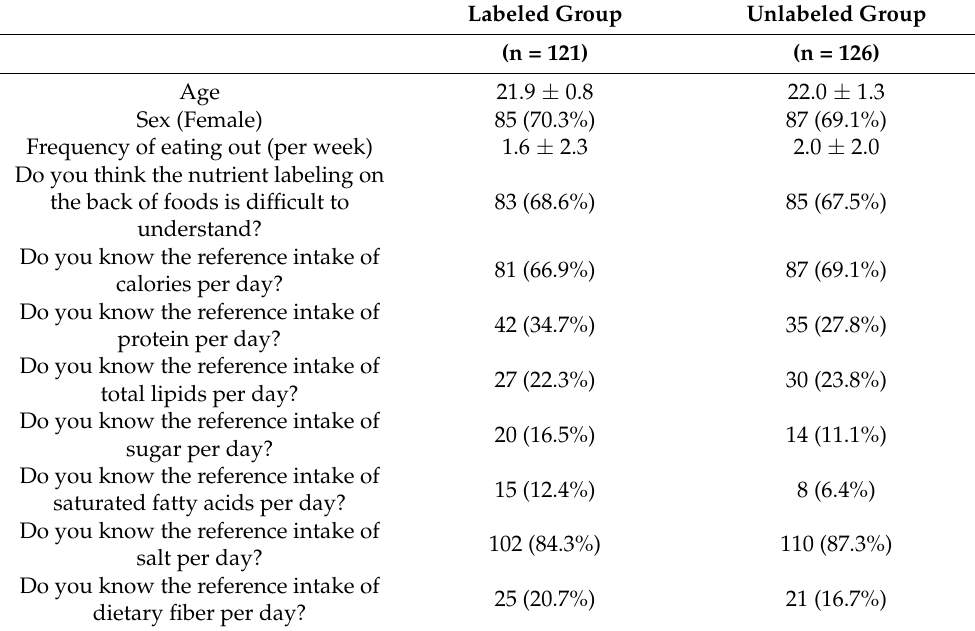
Table 1. Demographic and baseline characteristics of the study participants in the intervention and control groups.